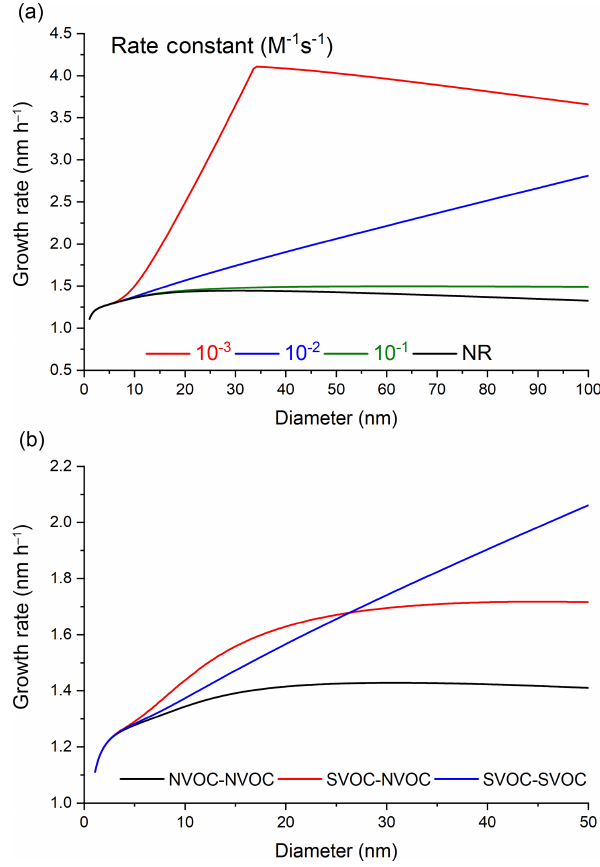
Figure 5. Growth rate vs. particle diameter. (a) Comparison of growth rates with different dimer formation rate constants for the SVOC–SVOC reaction. (b) Comparison of growth rates for SVOC–SVOC, NVOC–NVOC, and SVOC–NVOC reactions hav- ing a dimer formation rate constant of 10 − 2 M − 1 s − 1 . In these plots, the black line is equivalent to the particle diameter depen- dence in Fig.